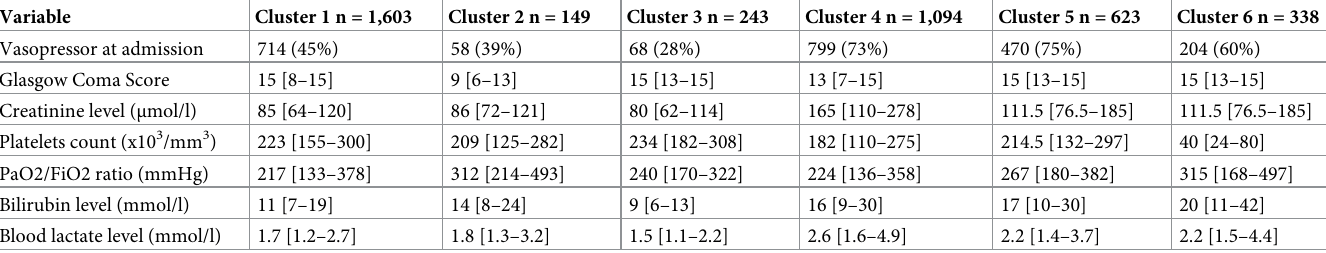
Table 4. Organ failure at admission by cluster (performed in training